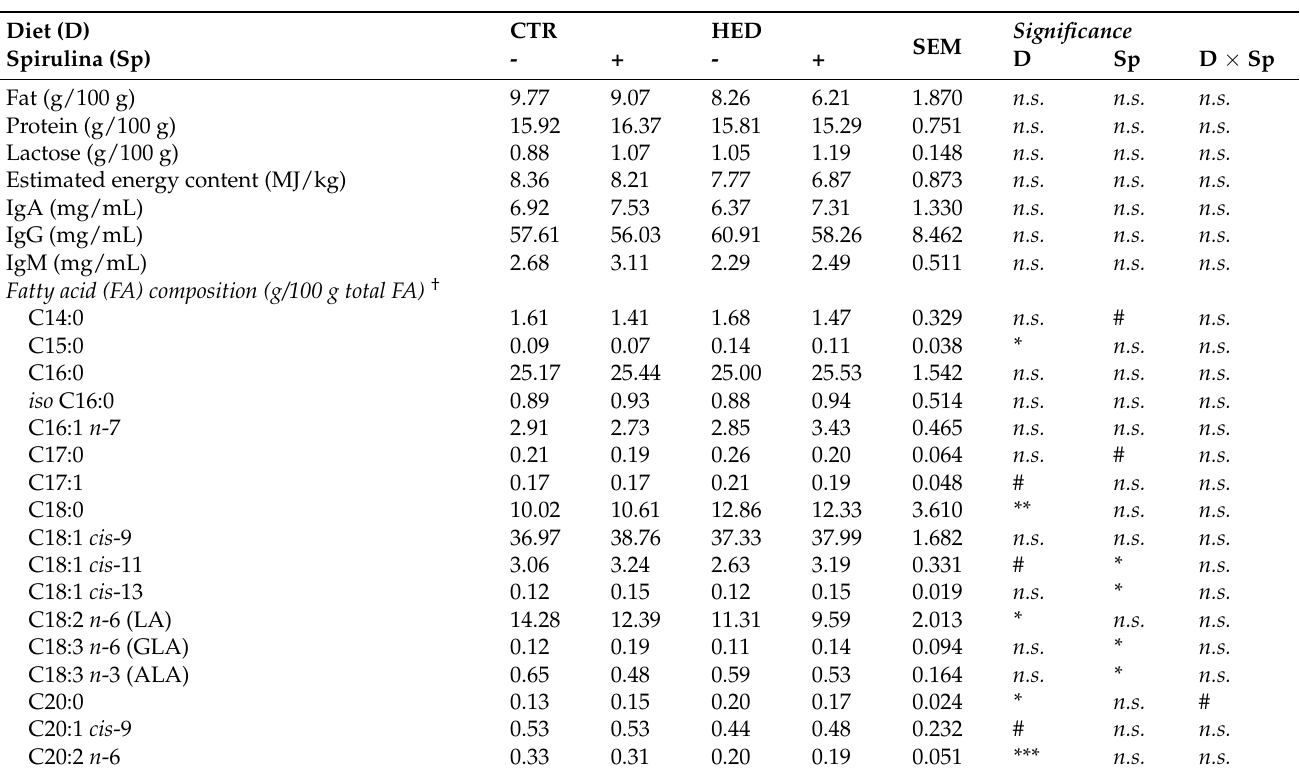
Table 3. Effect of a high-energy diet and spirulina supplementation on colostrum composition of the